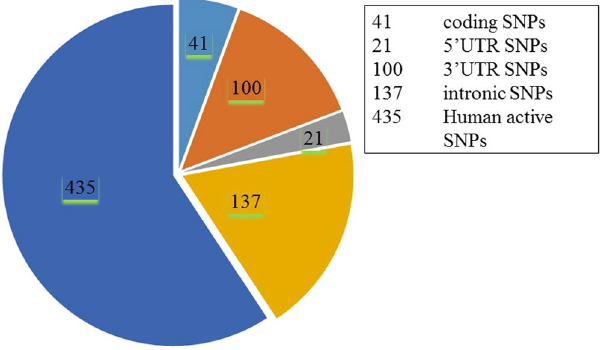
Figure 1. The pie-chart displays number of coding SNPs, 5 ′ UTR, 3 ′ UTR, intronic and other human active SNPs in human IL8 gene (based on the dbSNP